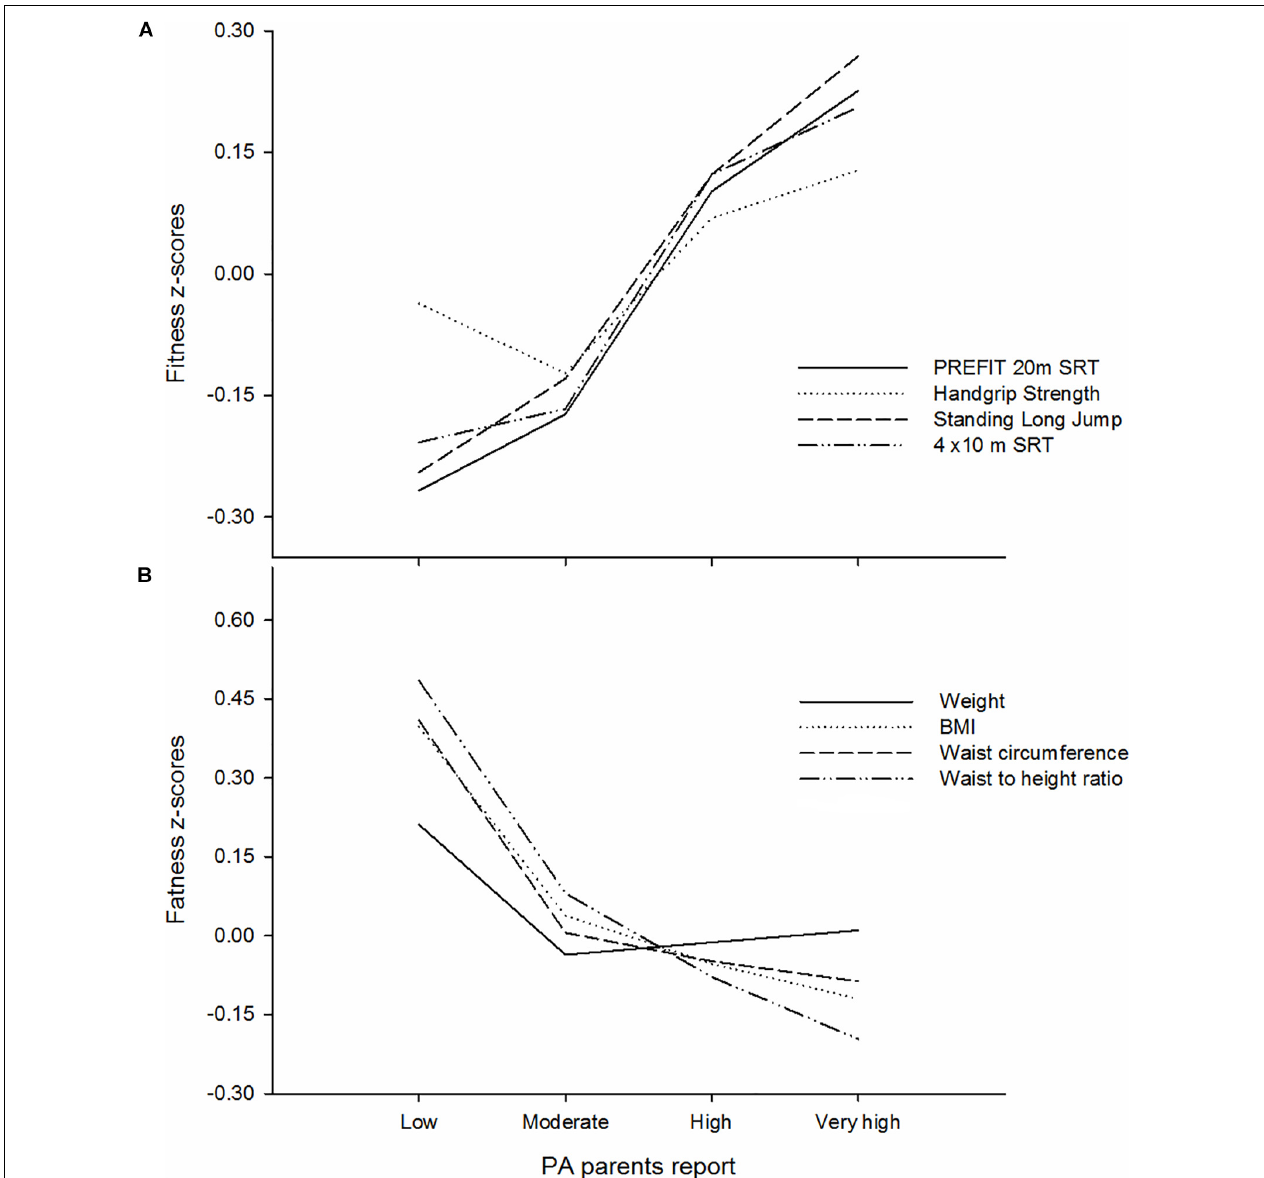
FIGURE 1 | Differences of objectively measured physical fitness z -scores (A) and body composition z -scores (B) across parents-reported physical activity levels in preschool children ( n = 3.179). SRT, shuttle run test; BMI, body mass index; PA, physical activity. The analyses were adjusted by age, sex, and maternal